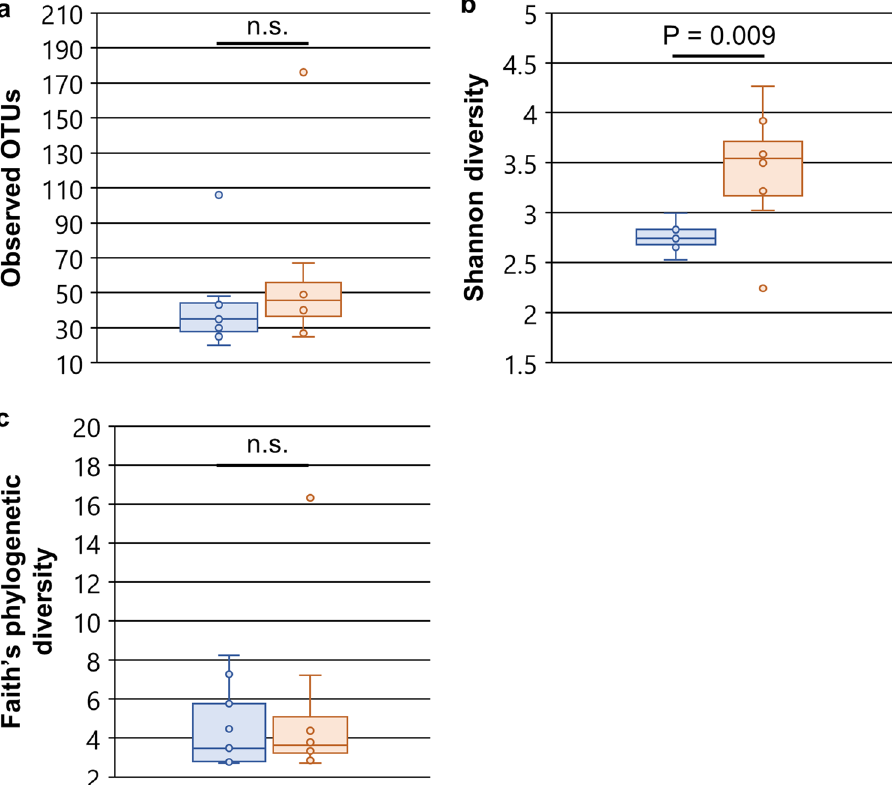
Figure 3. Comparison of alpha diversity metrics between hornet gut microbiomes. ( a ) Box-whisker plots of the numbers of observed OTUs, ( b ) Shannon diversity, and ( c ) Faith’s phylogenetic diversity. Points represent individual samples. Lines in the boxes correspond to the median of samples. Statistical significance was analyzed by Kruskal-Wallis test. n.s., not significant (P > 0.05). Blue, V. mandarinia ; orange, V. simillima . V. mandarinia , N = 9; V. simillima , N =